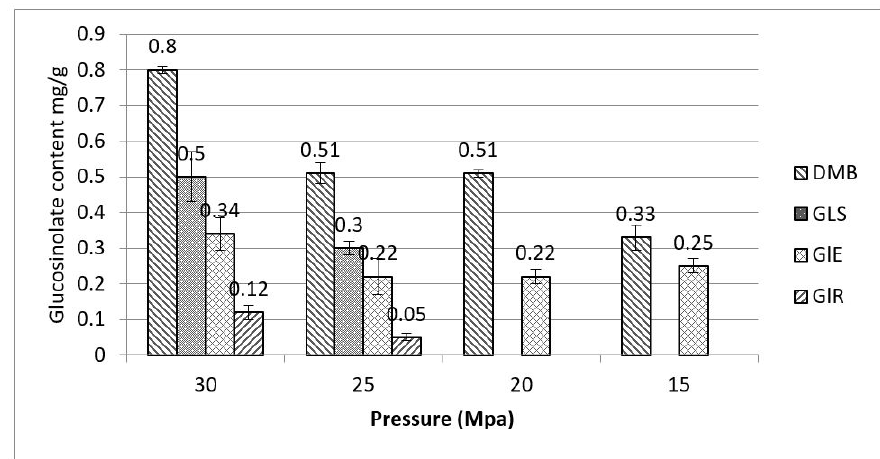
Figure 4. Glucosinolate composition (mg/g) of Eruca sativa extract obtained by SCO 2 at 65 ◦ C and different pressures ( p < 0.05 for 30 and 25 Mpa contents of DMB, GlS, GlE and GIR). Compounds are abbreviated as follow. Glucoerucin: GlE; Glucorafanin: GlR; Dimeric-4-mercaptobutylglucosinolate: DMB; Glucosativin: GlS.